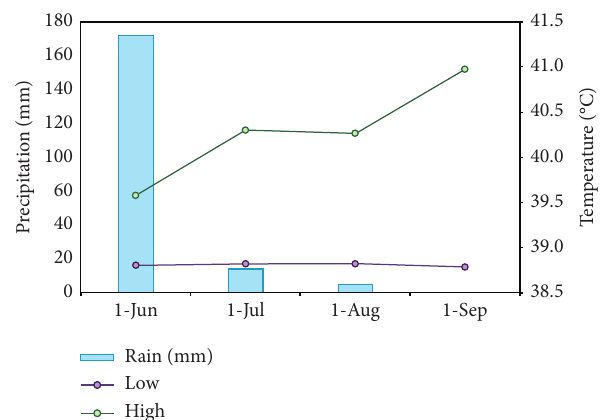
Figure 1: Temperature and precipitation data from June to Sep- tember 2018 in McAllen, TX, USA. Data were obtained from